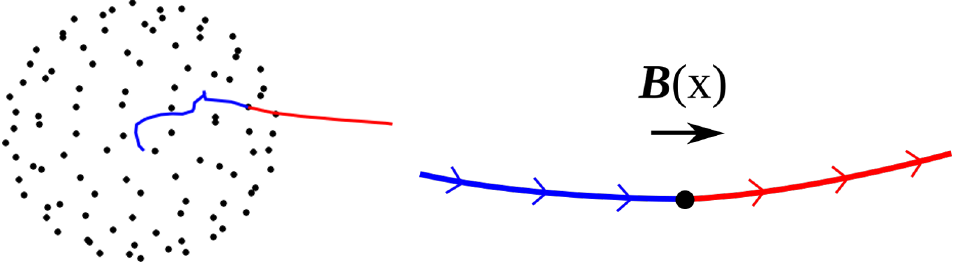
Figure 9 . Left : equally distributed points on a sphere enclosing a monopole. Right : red curve is the stream line for positive ζ and blue one is that for negative ζ